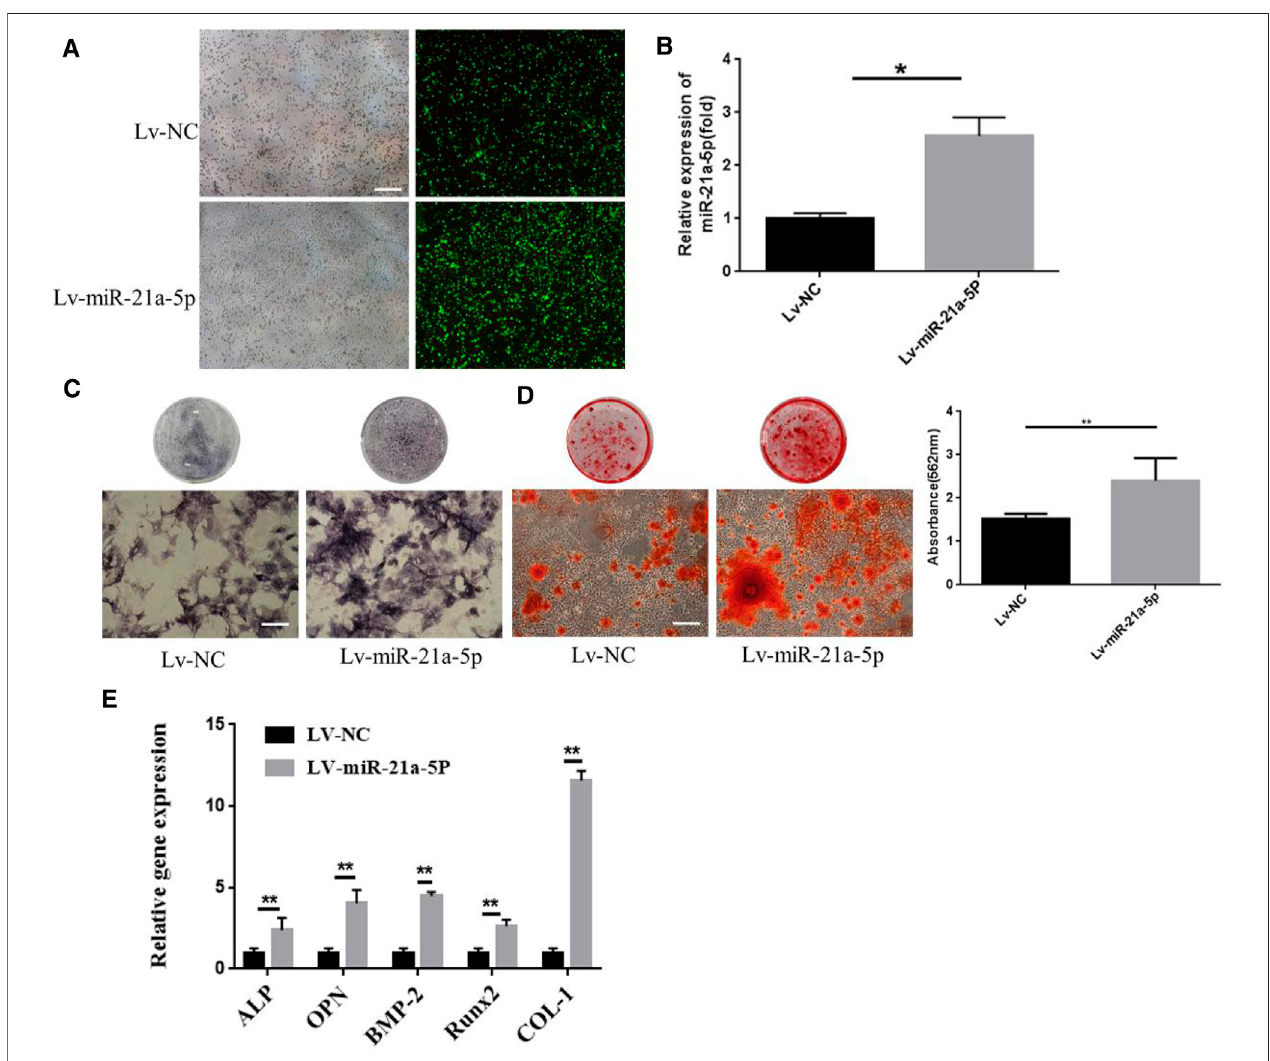
FIGURE 5 | Effect of miR-21a-5p overexpression in M1 macrophages on osteogenic differentiation of BMSCs. (A) MiR-21a-5p was overexpressed using lentivirus transfection technique. (B) QPT-PCR was used to verify the expression of miR-21a-5p. (C) ALP staining in BMSCs (Scale bars, 100 μ m). (D) Alizarin red S staining and quanti fi cation in BMSCs (Scale bars, 100 μ m). (E) The expression ofosteogenic gene was detected by qRT-PCR. Dataare presented as mean ± SD. *p < 0.05, **p < 0.01 represent signi fi cant differences between the indicated columns.